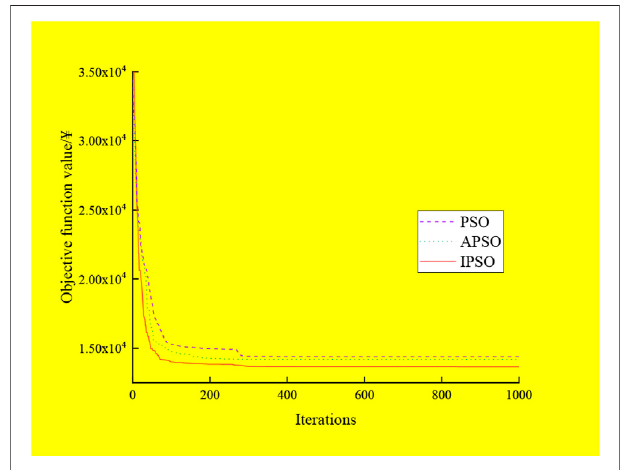
FIGURE 5 | Convergence curve of the objective function value.